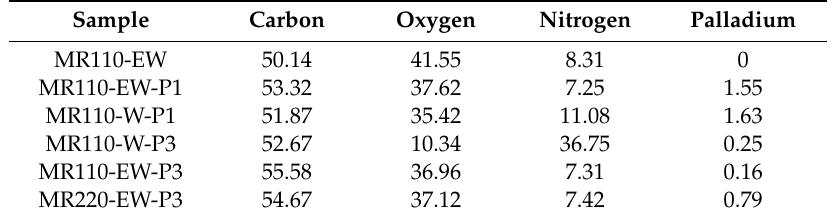
Table 2. Carbon, Oxygen, Nitrogen and Palladium in various Pd-MRs catalyst based on